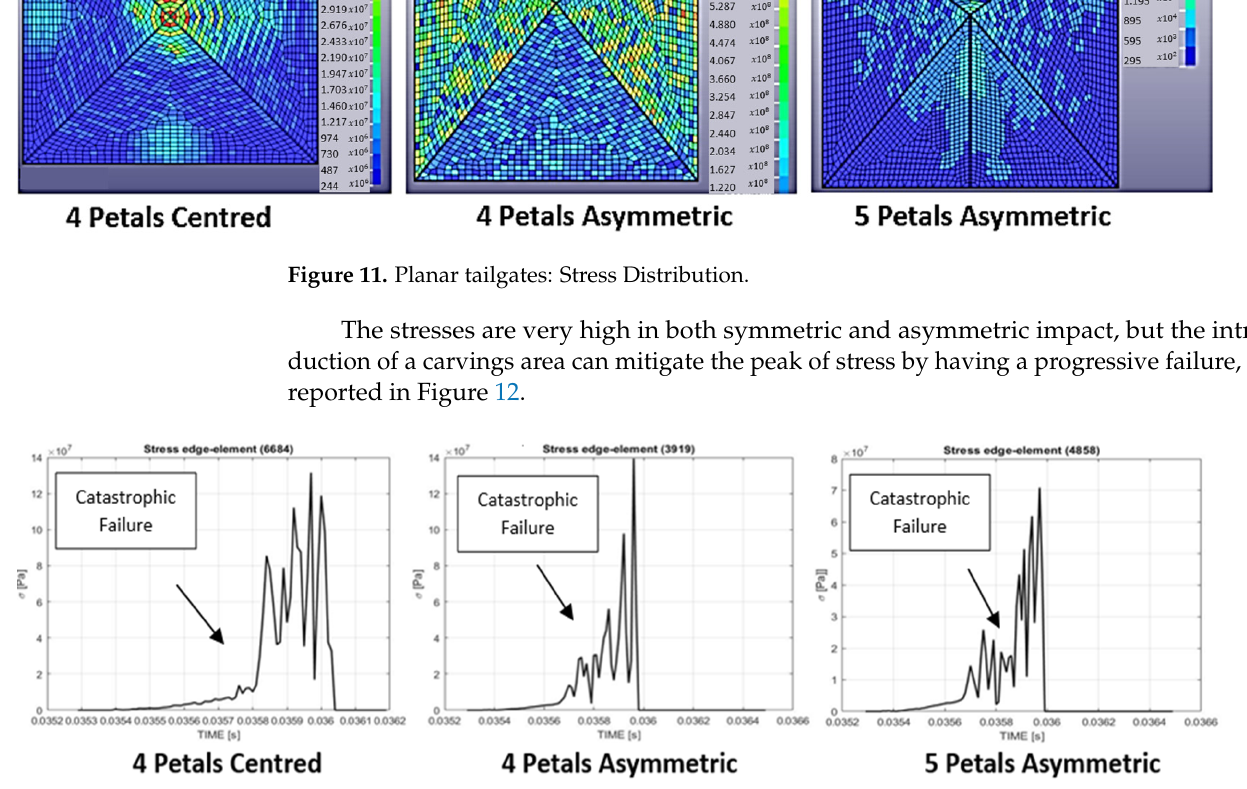
Figure 12. Planar Tailgates: stress